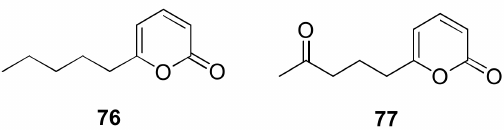
Figure 6. The structures of 6- n -pentyl-2 H -pyran-2-one and viridepyronone ( 76 and 77 )